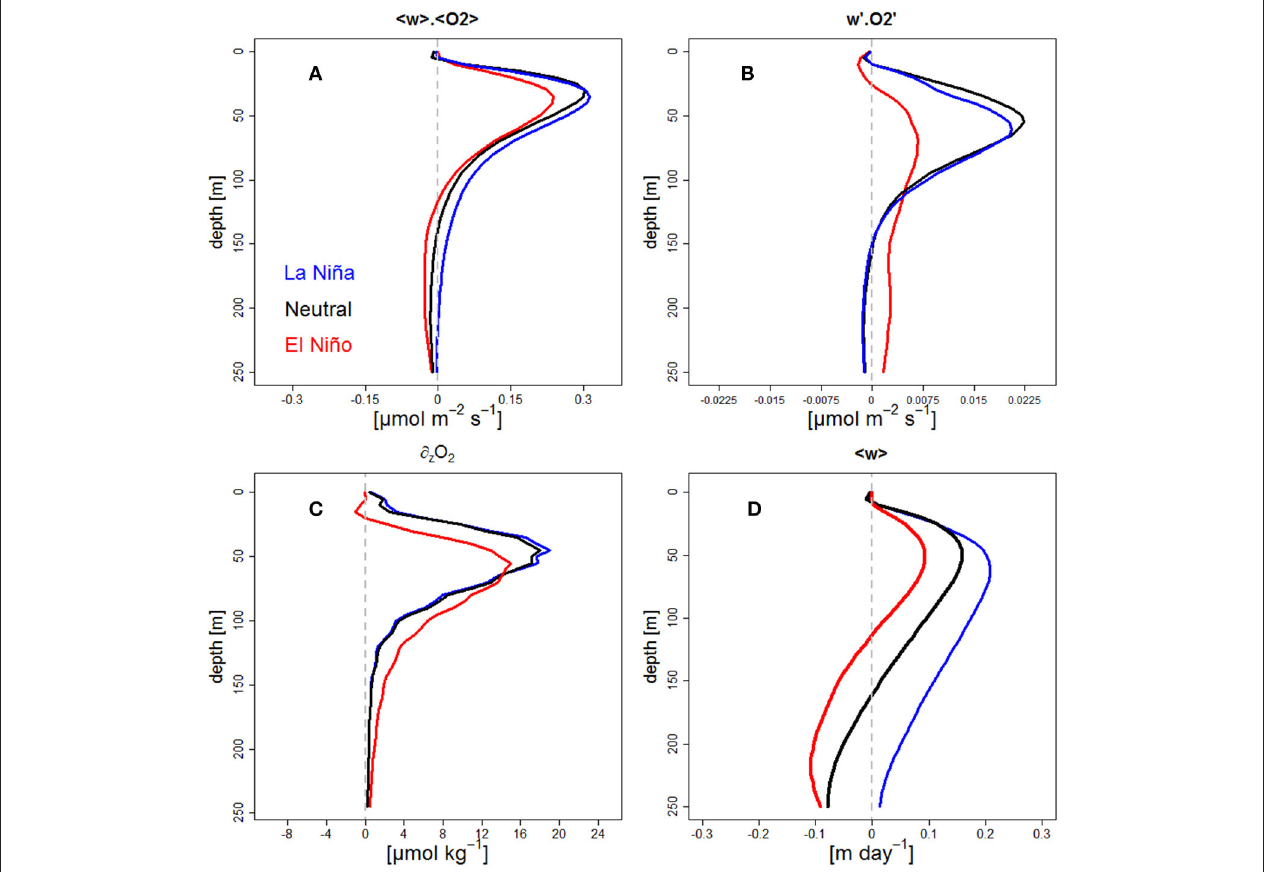
FIGURE 7 | Vertical profile of DO mean vertical flux ( A , in µ mol O 2 m − 2 s − 1 ) and DO eddy vertical flux ( B , in µ mol O 2 m − 2 s − 1 ), DO vertical gradient ( C , in µ mol O 2 kg − 1 m − 1 ) and vertical velocity ( D , in m day − 1 ) for Neutral (black line), LN (blue line), EN periods (red line). Profiles were computed in an oceanic band between 100 and 500km from the coast and 6 ◦ S − 14 ◦ S. In (C) dashed gray line represents the depth of the OMZ upper limit (22 µ mol O 2 kg − 1